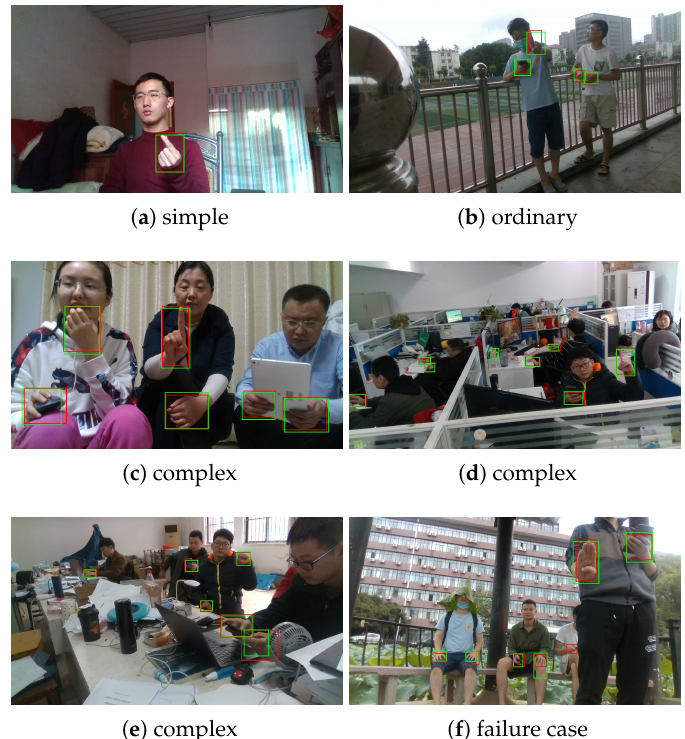
Figure 9. Hand detection results of Ours. The red bounding boxes denote the ground-truth labels, and the green bounding boxes denote the detection